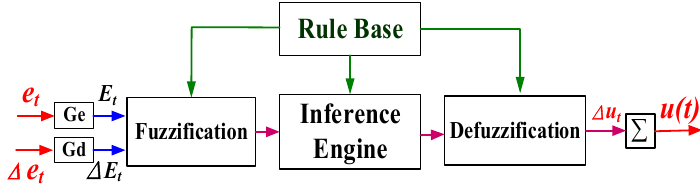
Figure 5. Block diagram of the error fuzzy controller.